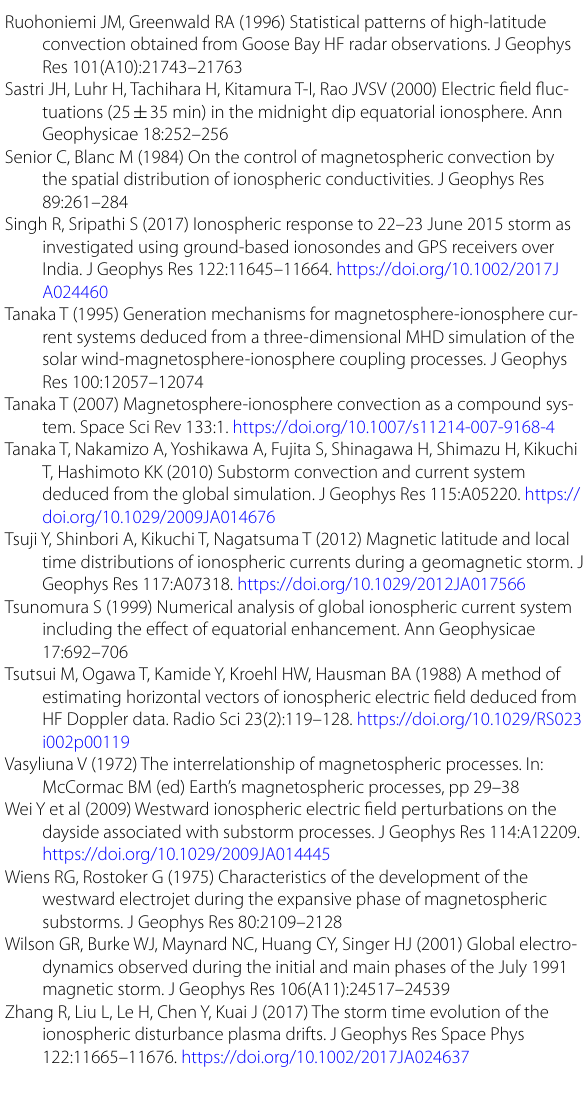
figuration: explosive growth phase. J Geophys Res 97(12):19311–19324 Peymirat C, Richmond AD, Kobea AT (2000) Electrodynamic coupling of